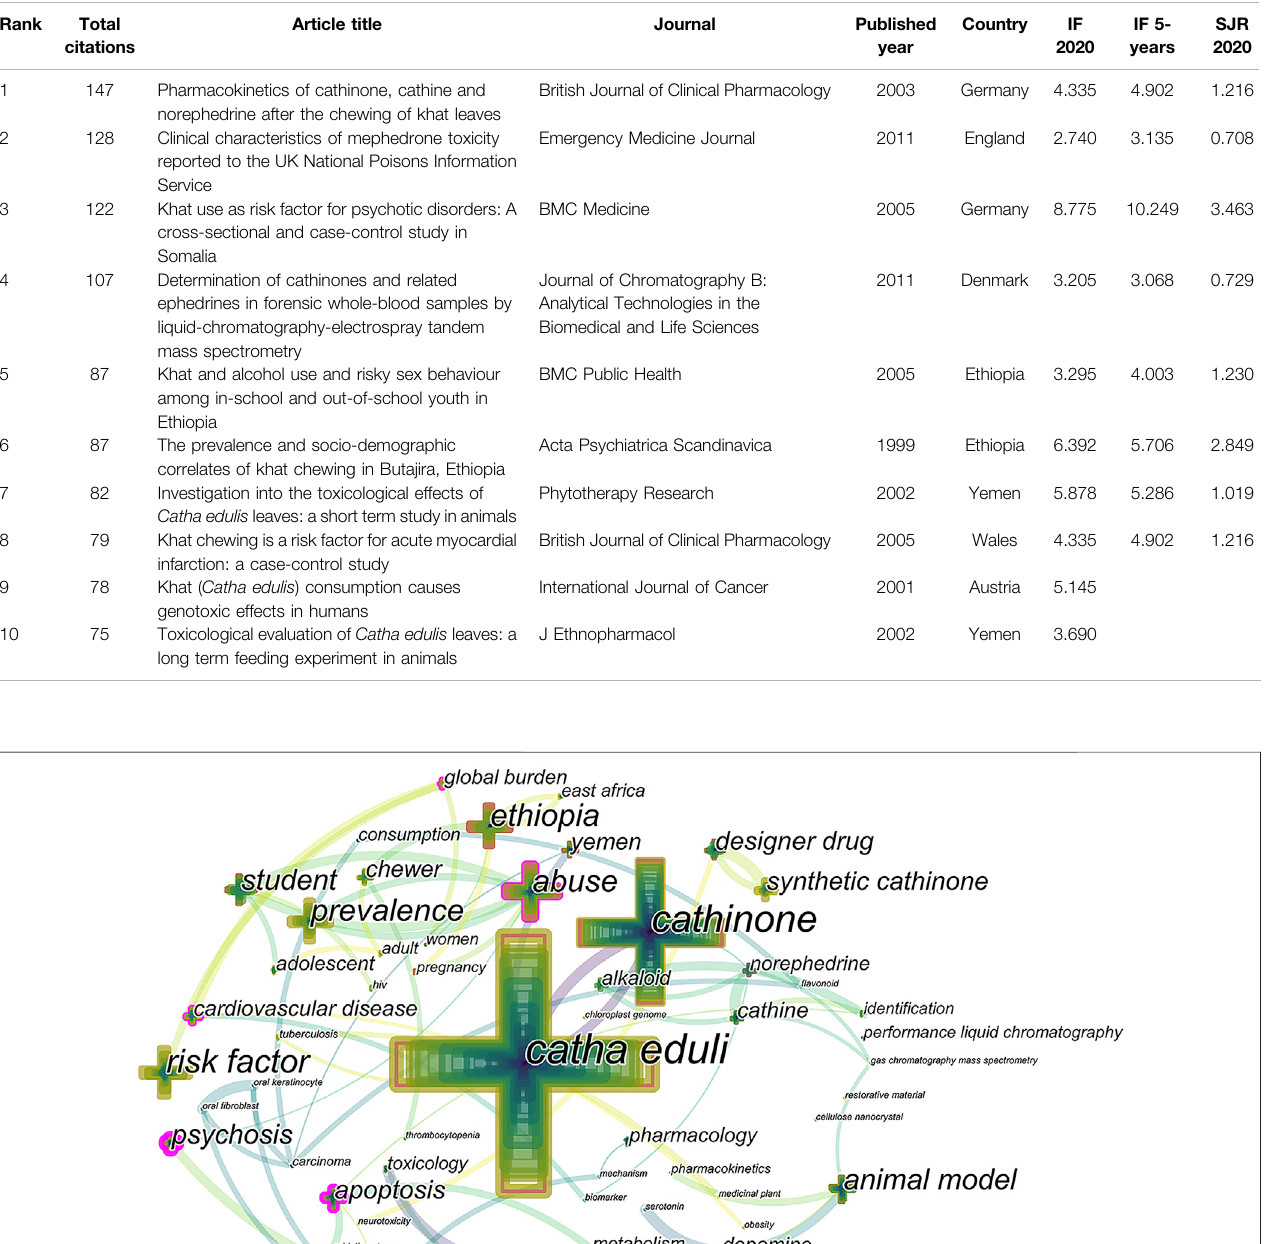
TABLE 2 | The characteristics of highly cited articles.